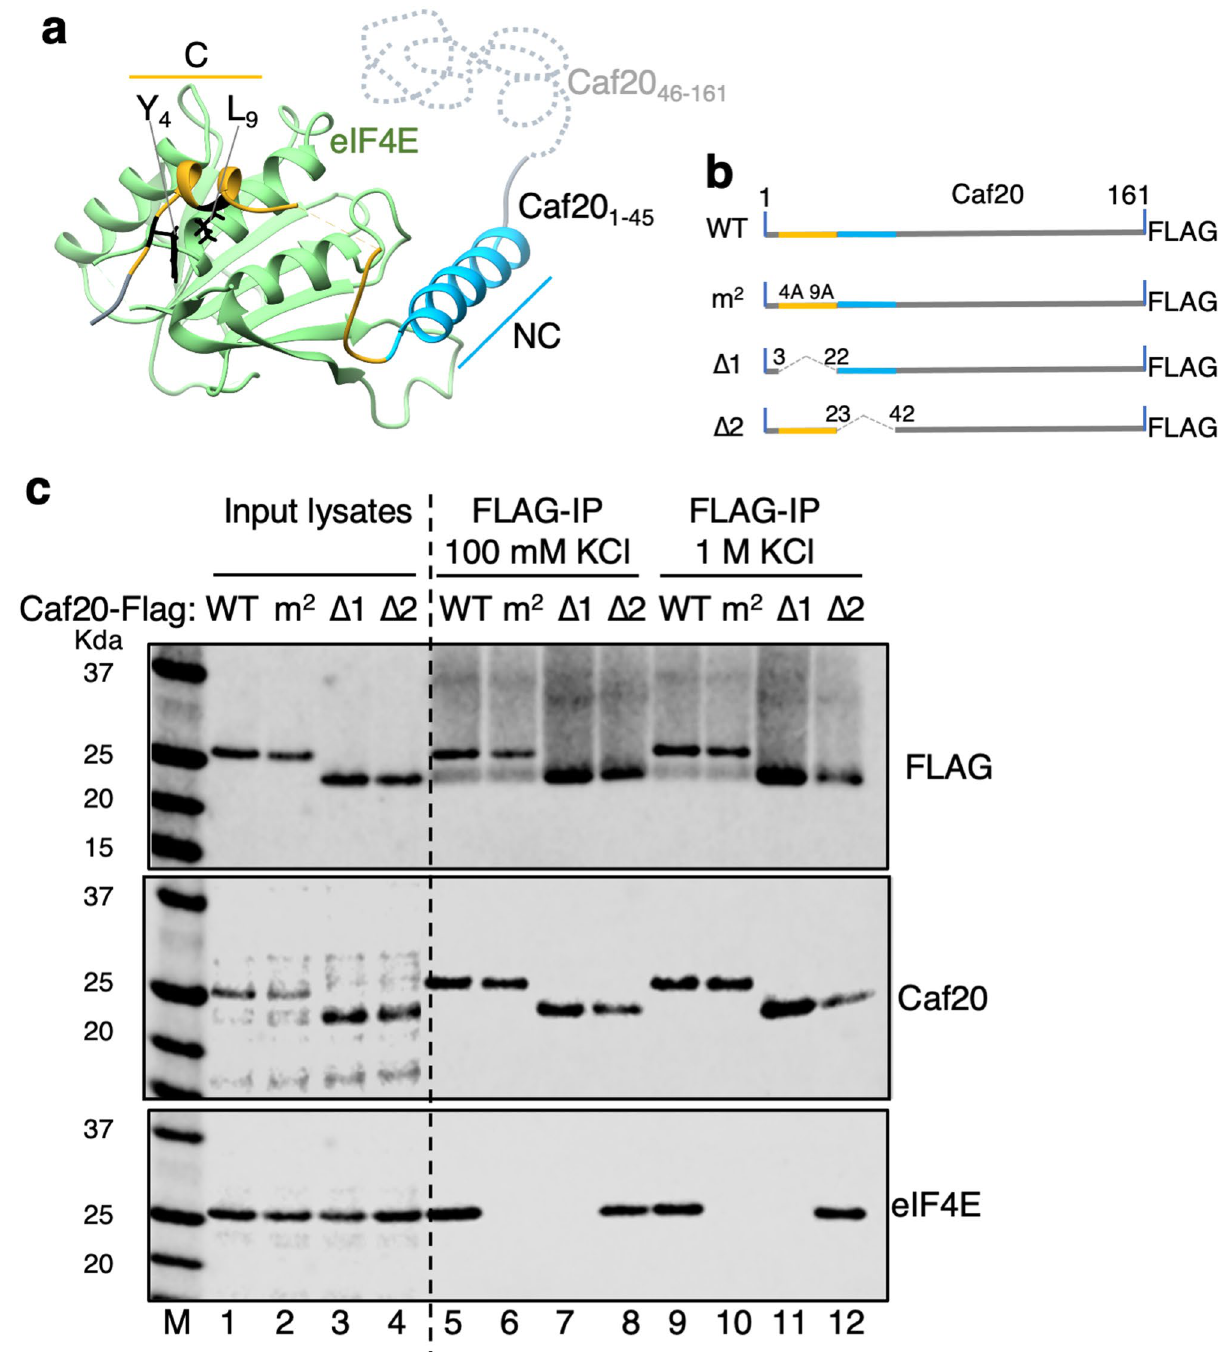
Figure 1. Caf20 binds tightly to eIF4E, except when canonical interaction is eliminated. ( a ) Caf20 1–45 interacts with eIF4E via 2 alpha helices. Cartoon from PDB 6FC3 (ref 9) with canonical (C) and non-canonical helices interacting with eIF4E. ( b ) Cartoon of Flag tagged Caf20 showing m 2 and deletion alleles each removing 20 amino acids. ( c ) Western blots showing expression in yeast extracts (lanes 1–4) and immunoprecipitation of Caf20-FLAG (Top and middle) and native eIF4E (bottom) with Flag resin (lanes 5–12). Lanes 5–8 IPs washed with 100 mM KCl, lane 9–12 1 M. Note: faint bands in lanes 5, 6, 9, 10 that co-migrate with Caf20 ∆1 represent cross-reactivity with M2 Flag antibody light-chain co-eluted from resin (so are absent when probed with an antibody to the C-terminus of Caf20, middle